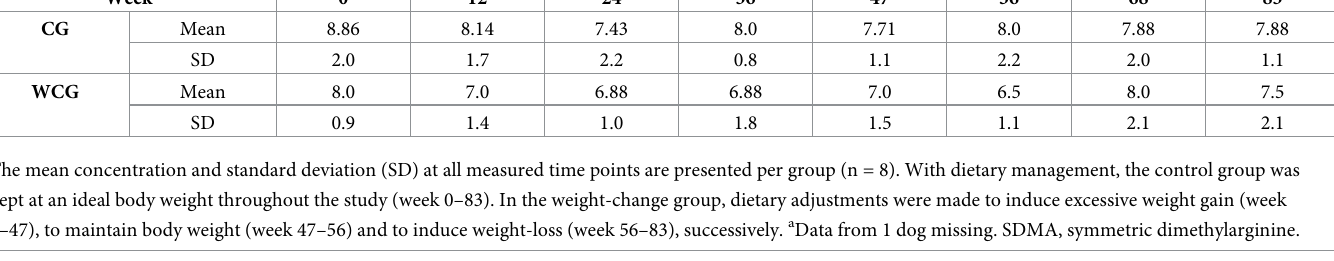
Results concerning sCr and GFR were also previously published by Liu et al. [27]. Briefly, sCr concentrations were within the laboratory reference interval for all dogs and was not sig- nificantly different between the CG and WCG over time. Similarly, no significant difference was detected for GFR between both groups. The profile of GFR from the two groups were par- allel to each other, with slightly higher values in the CG. For both groups, a slight decrease could be observed until week 36. Afterwards, GFR of both groups showed a gradual increase until the end of the study.